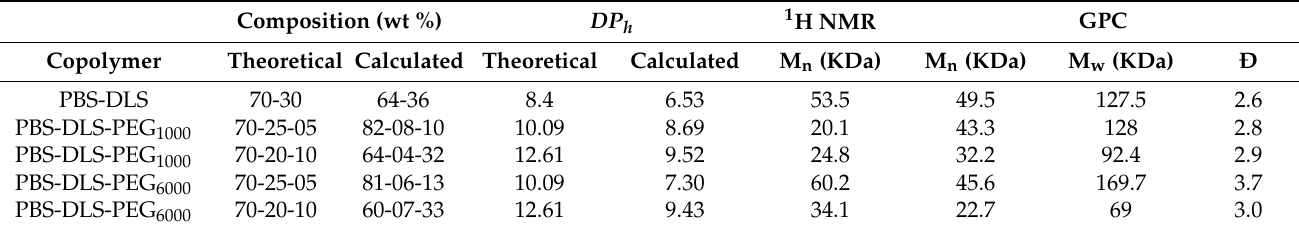
Table 2. The molecular weight calculated from 1 H NMR results and from GPC, the weight and molar percentage ratio between the hard and soft